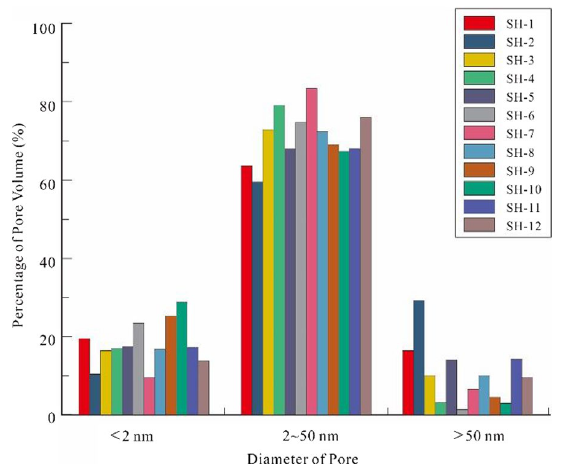
Fig. 9 Histogram of pore volume distribution based on the IUPAC classification